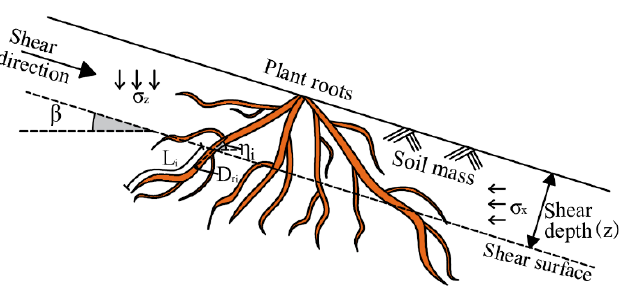
Figure 22. Schematic diagram of roots spatial geometric parameters on a certain depth shear